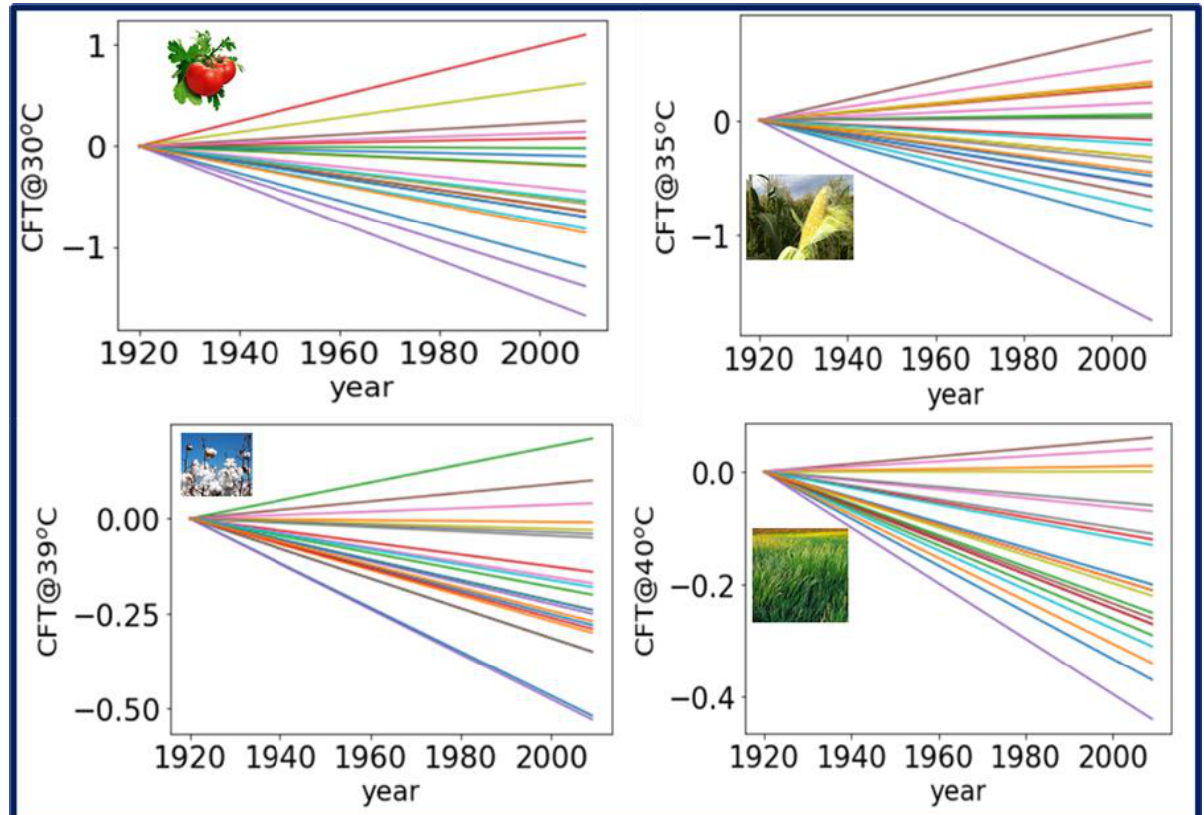
Figure 7. Long-term linear trends (colored lines) showing the number of days with crop failure temperature (CFT) at four different temperatures, clockwise from top, at 30 °C, 35 °C, 39 °C, and 40 °C. The picture inside each block represents the examples of crops at different CFT thresholds.